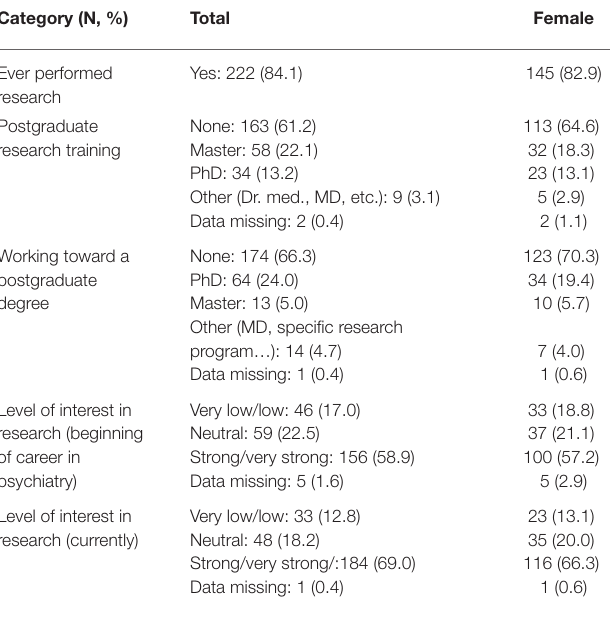
TABLE 3 | Results of research